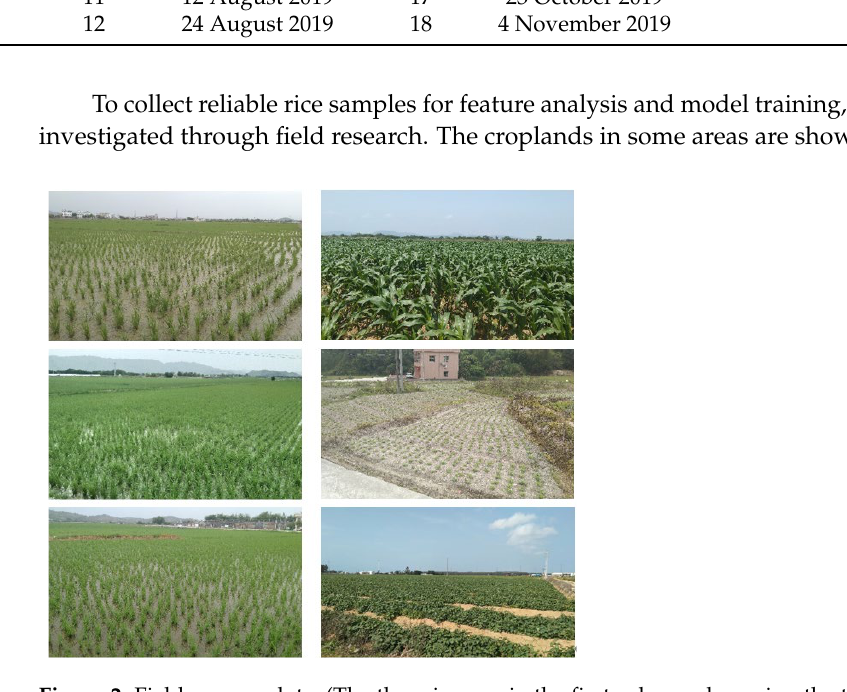
Figure 2. Field survey plots. (The three images in the first column show rice; the three images from top to bottom in the second column show corn, peanut and sweet potato).